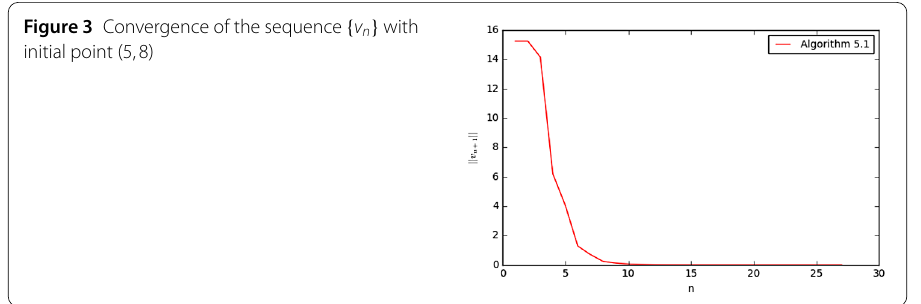
Figure 3 Convergence of the sequence { v n } with initial point